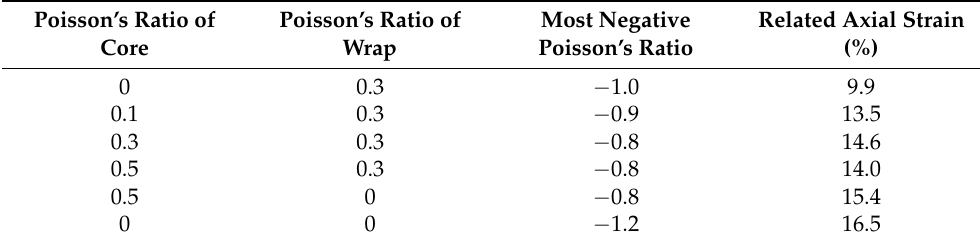
Table 1. Auxetic property of complex yarns with filaments with different Poisson’s ratio s. Poisson’s Ratio of